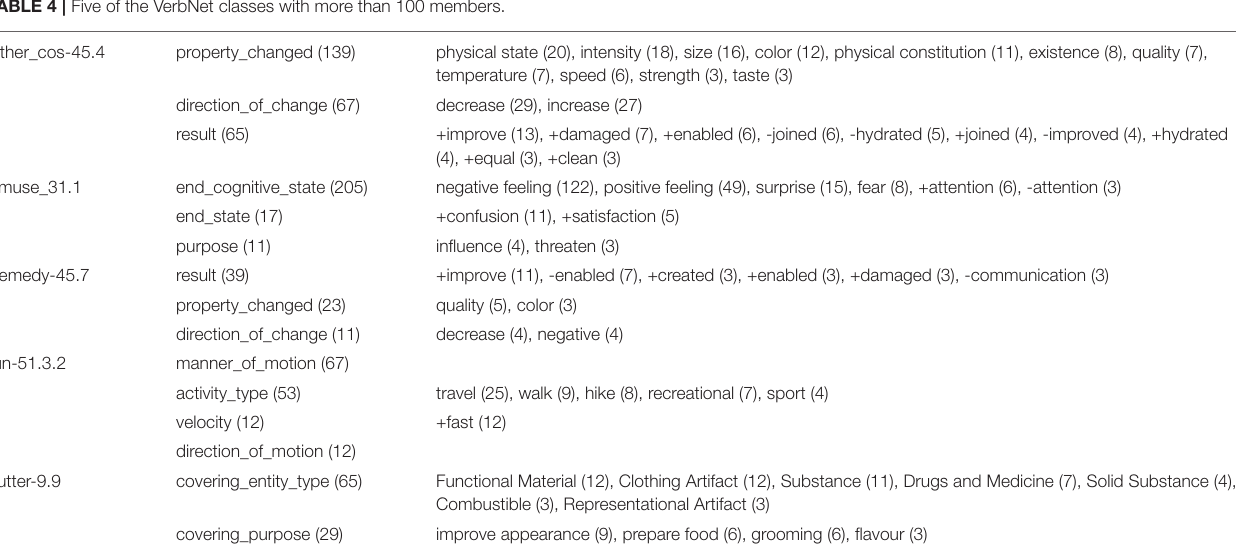
TABLE 4 | Five of the VerbNet classes with more than 100